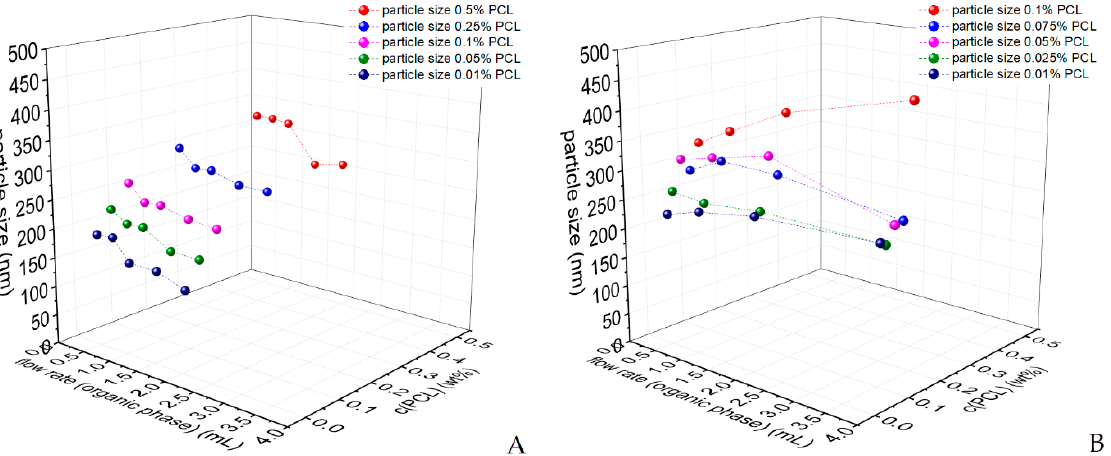
Figure 3. Particle sizes obtained by using different concentrations of PCL and varying flow rates in the continuous process (Y-mixer) ( A ) with a ratio o/w of 1:4, and ( B ) with a ratio o/w of 1:1.